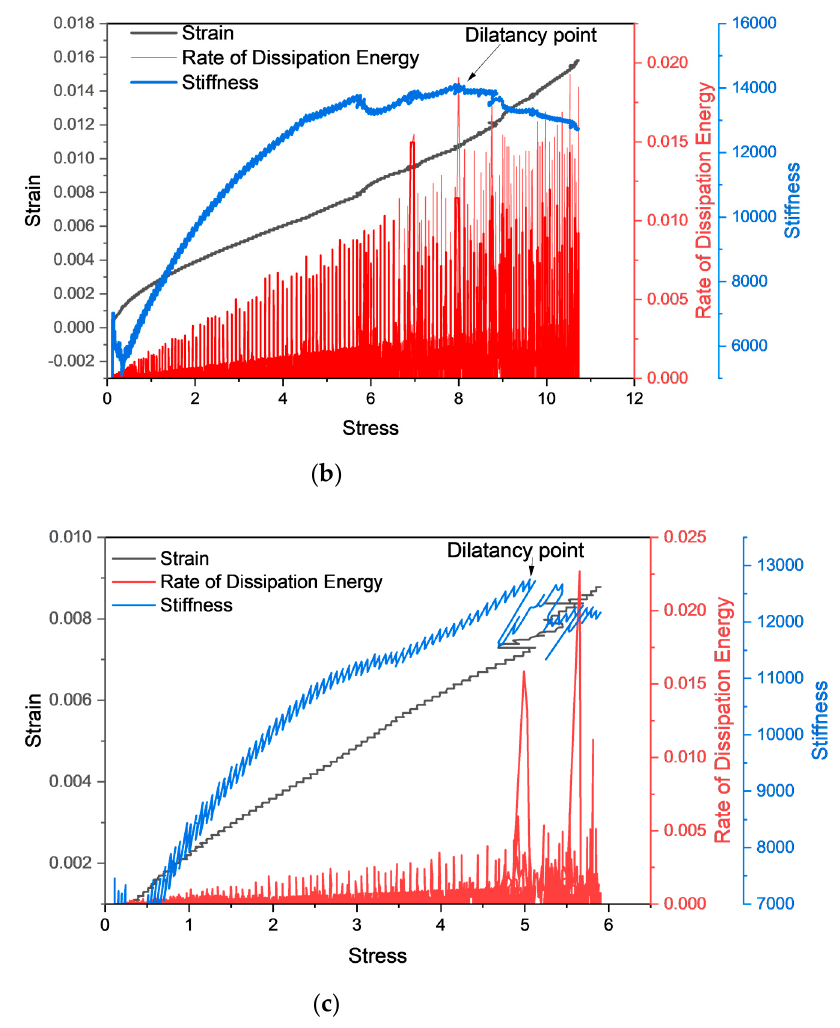
Figure 12. Illustration relation of strain, stiffness, and rate of dissipation energy over the stress of ( a ) dry sample, ( b ) natural sample, ( c ) saturated sample.